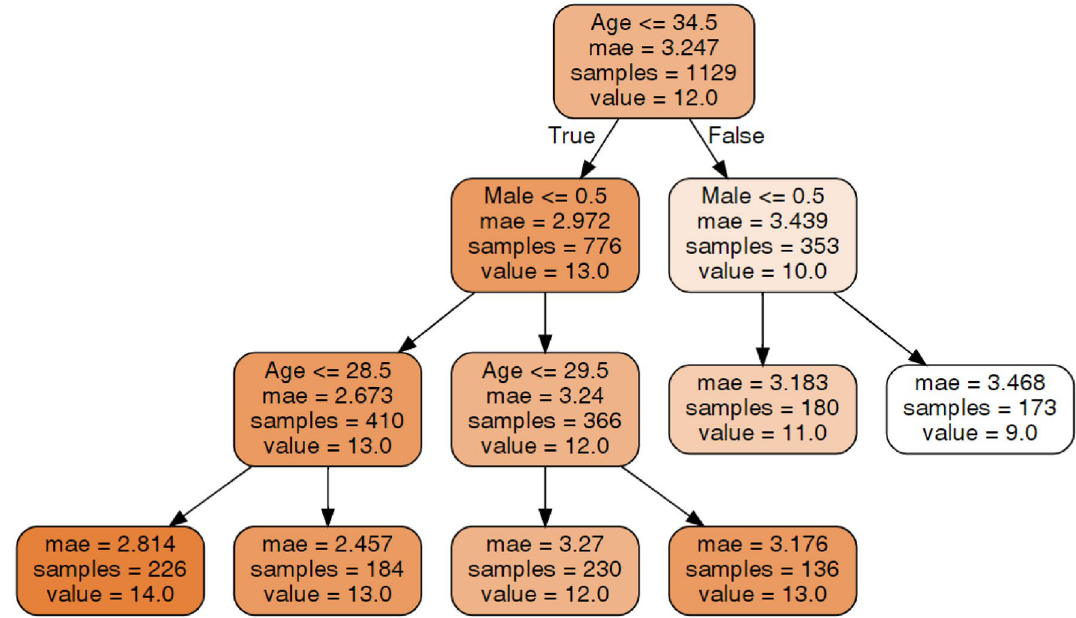
Figure 3. Decision tree for Oral Behavior Checklist (OBC). Source: author-generated tree using the sklearn and graphviz libraries.